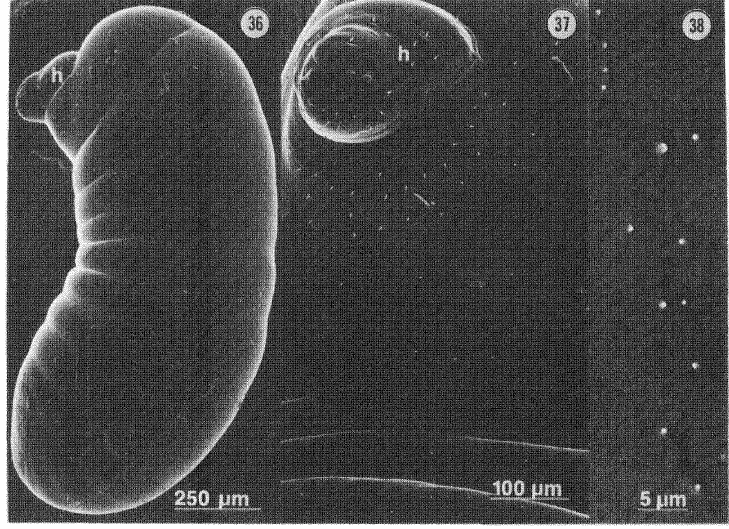
Figs. 36-38. Fig. 36. Lateral view of Iridomyrmex pruinosum. Head (h). Fig. 37. Anteroventral body region of L pruinosum. Note short, simple hairs (arrow). Praesaepium (arrow). Fig. 38. Ventral, metathoracic spinules of L